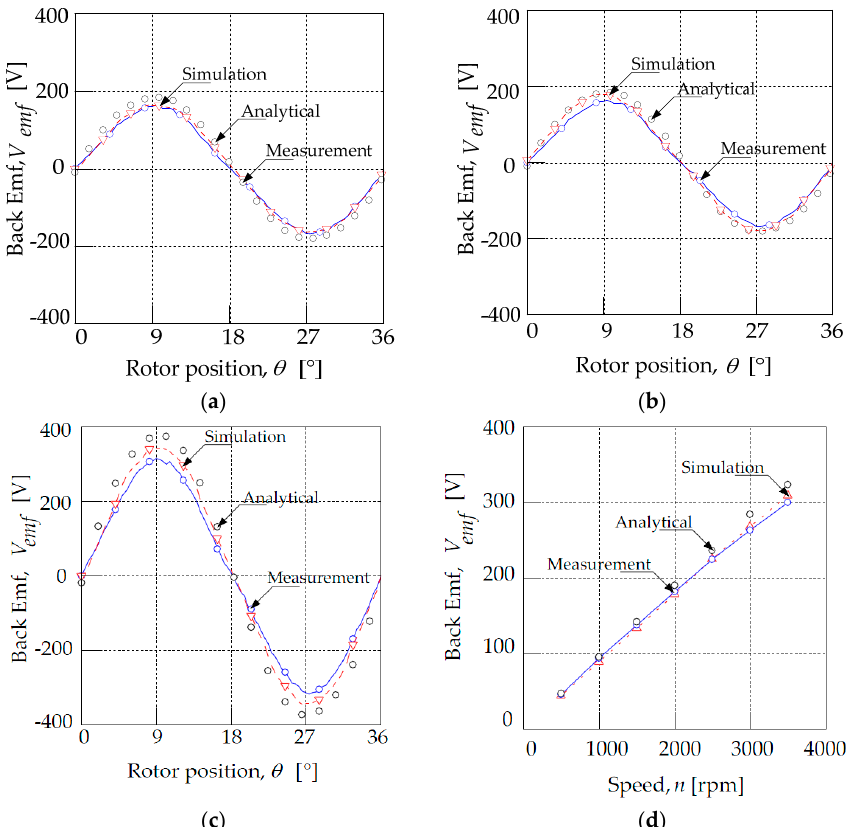
Figure 15. Back EMF of DSSR-PMG, ( a ) Inner back EMF; ( b ) Outer back EMF; ( c ) Inner + outer back EMF; ( d ) Back EMF at different operating speed.